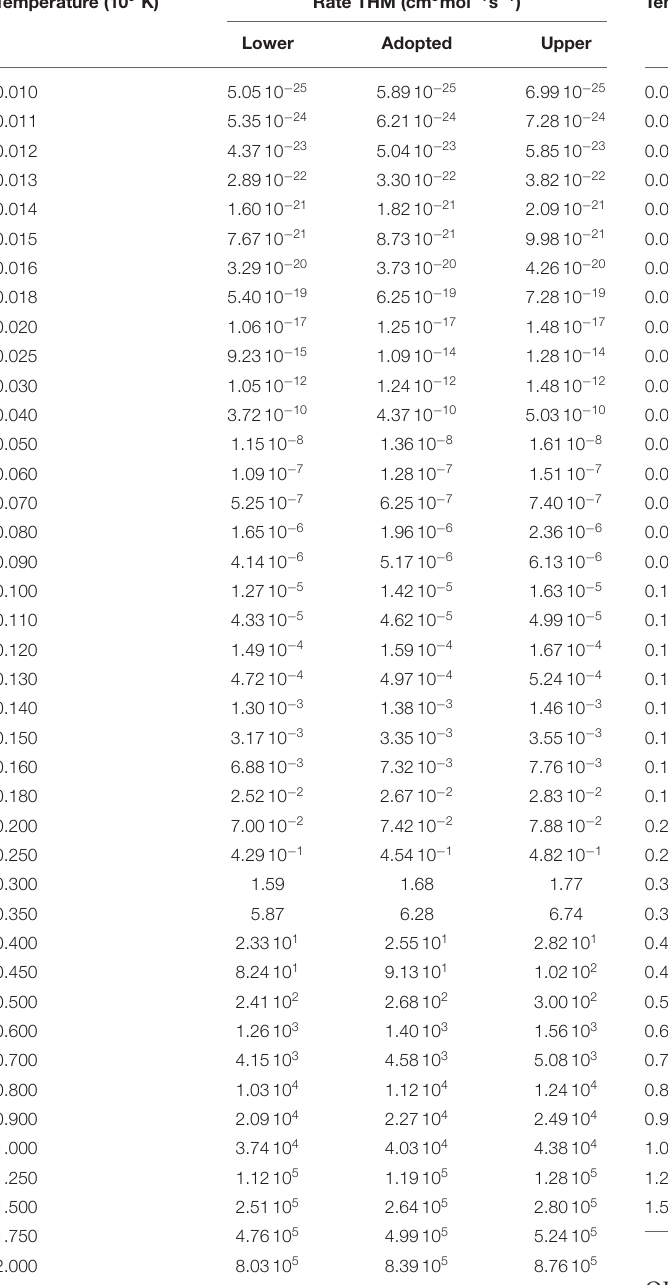
TABLE 2 | Rate of the 17 O( p , α ) 14 N reaction. Temperature (10 9 K)